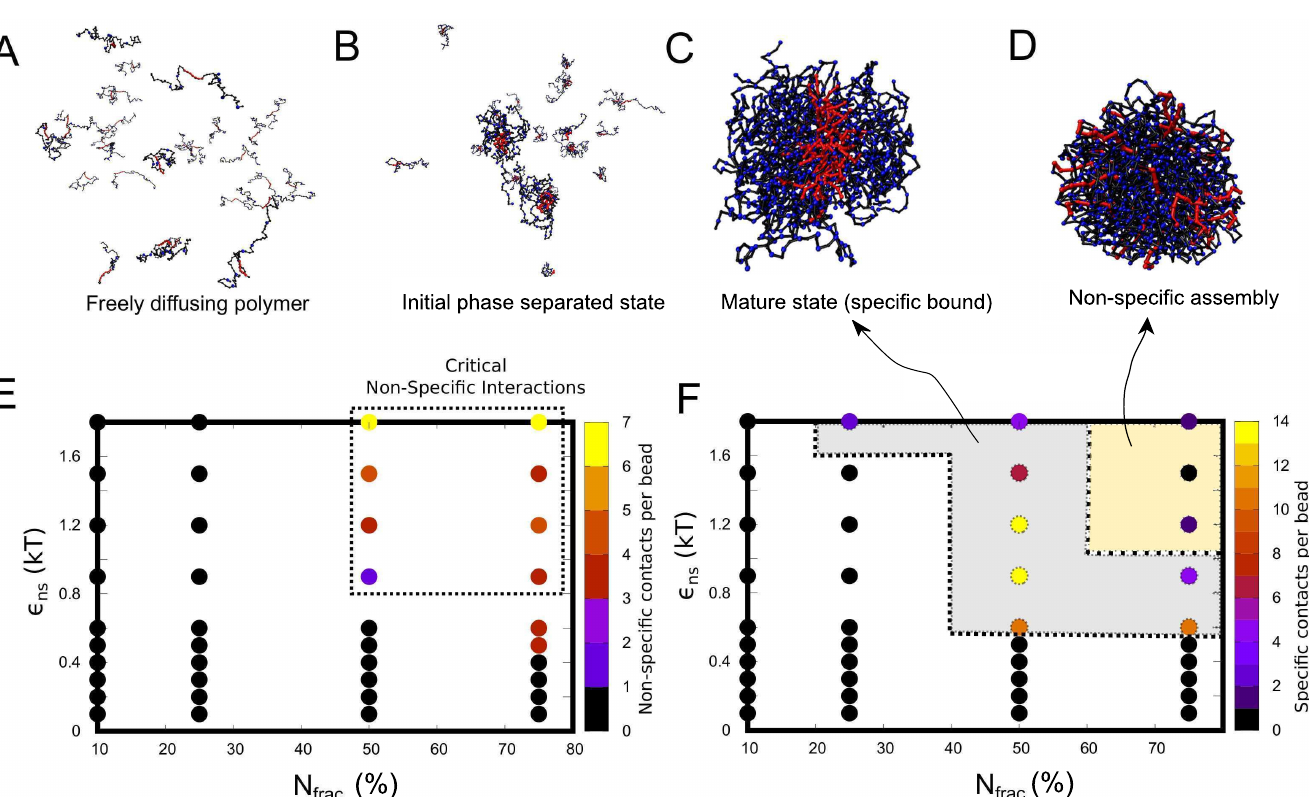
Fig 8. Varying fraction of non-specifically interacting residues. Snapshots of A) freely diffusing polymer in the simulation. B) early non-specifically bound initial multimer state, C) solid like mature state and D) non-specifically assembled state for a 3-bead polymeric system. E) Non-specific contacts, N ns , per bead is plotted for varying non-specific interaction � ns and fraction of non-specifically interacting beads (N frac , given in percentage). The dotted box indicate the critical values of non- specific interaction and N frac , fraction of non-specific beads required for formation mature multimer complex. F) Specific contacts, N sp , as a function of varying non- specific interaction, � ns , and fraction of non-specifically interacting beads. The grey area covered inside dotted line is the region where the formation of multimer leading to mature complex is plausible. The simulations were performed for a fixed specific interaction strength, � sp of 1.2 k B T.